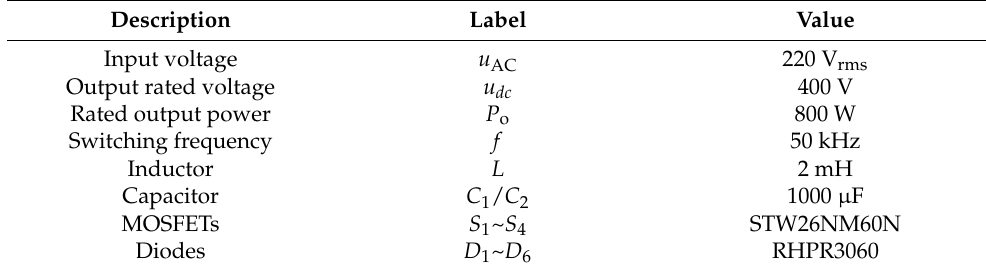
Figure 9. Experimental prototype platform. Table 4. Main Parameters of The Experimental